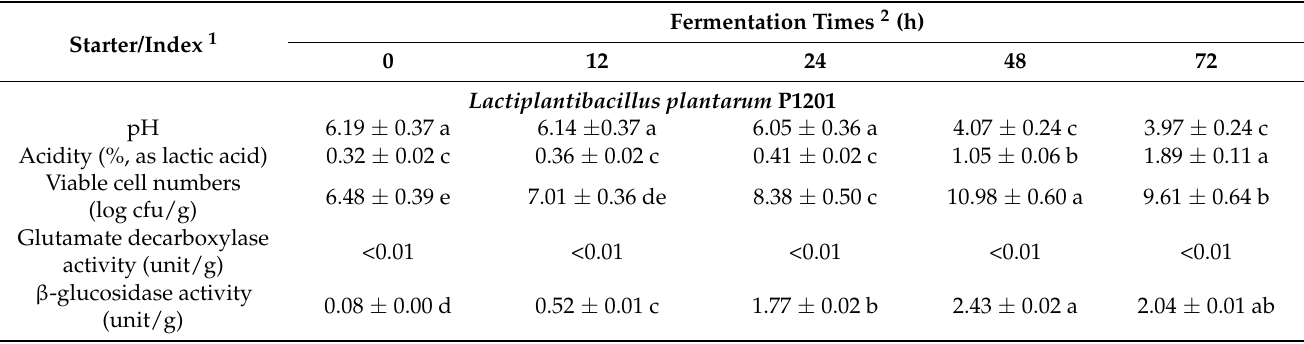
Table 1. Changes of pH, acidity, and viable cell numbers during the fermentation of isoflavone- enriched soybean leaves (IESLs) with the use of Lactiplantibacillus plantarum P1201 and/or Levilacto- bacillus brevis BMK184 as